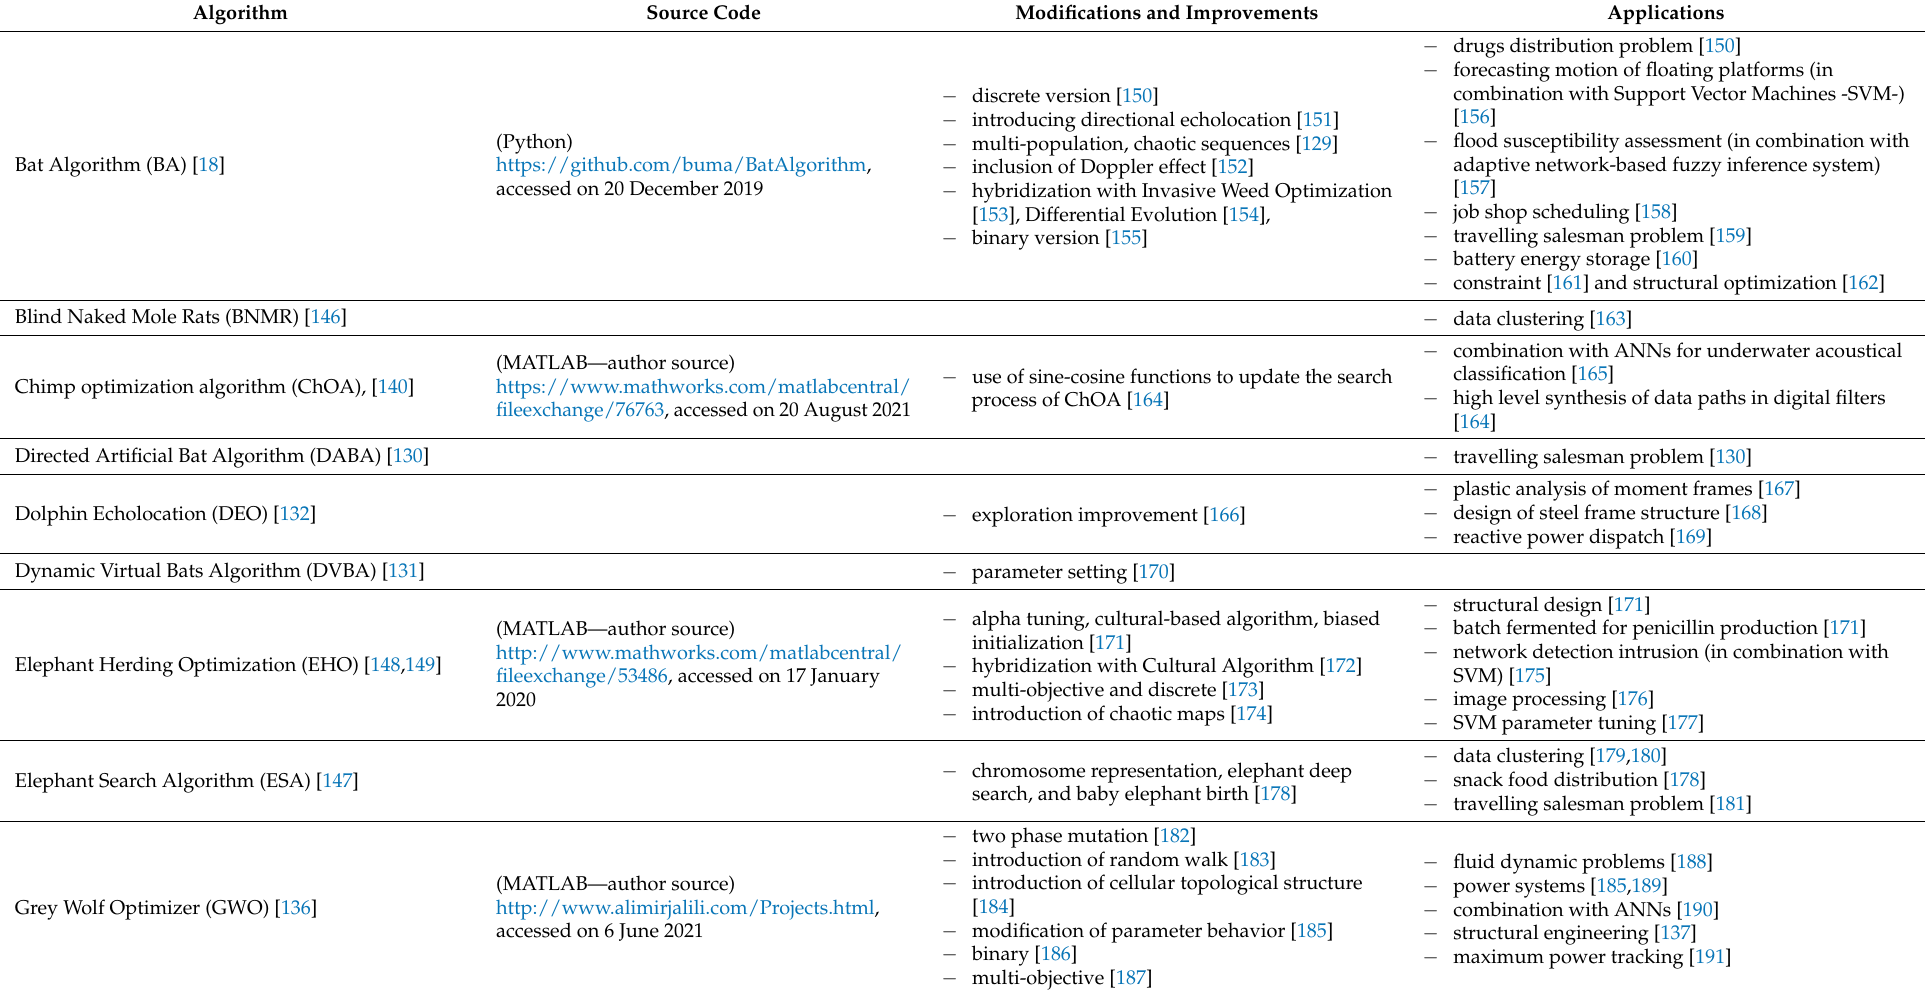
Table 2. Improvements and applications for some mammal-inspired metaheuristics (alphabetically